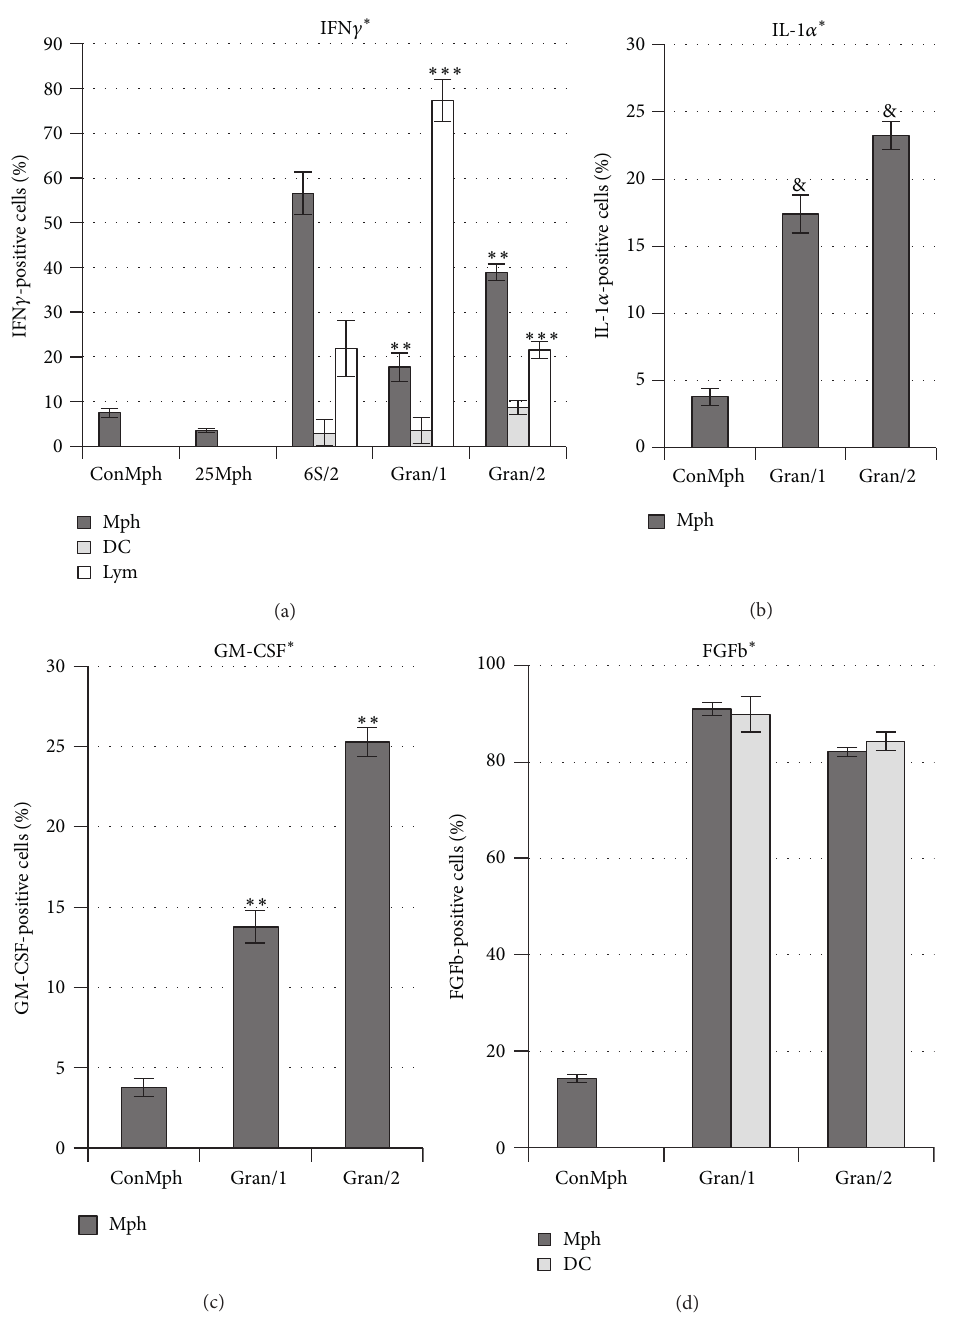
Figure 6: The macrophages (Mph), dendritic cells (DC), and lymphocytes (Lym) with production of (a) IFN 𝛾 , (b) IL-1 𝛼 , (c) GM-CSF and (d) FGFb. The independently examined objects are control peritoneal macrophages (ConMph) from three intact mice, peritoneal macrophages obtained from mouse 25 (25Mph), that was intraperitoneally infected with the BCG vaccine for two months, cells in leukocyte infiltrates from mouse 6S/2 and granulomas from the spleens of three to six mice after one and two months (Gran/1 and Gran/2, resp.) of BCG infection in vivo and ex vivo culture after a few days. Data are means ± SEM. ∗ 𝑃 < 0.001 (comparing cytokine-positive macrophages in controls (ConMph and 25Mph) and Gran/1 and Gran/2 granulomas), ∗∗ 𝑃 < 0.01 , ∗∗∗ 𝑃 < 0.001 , & 𝑃 < 0.05 .